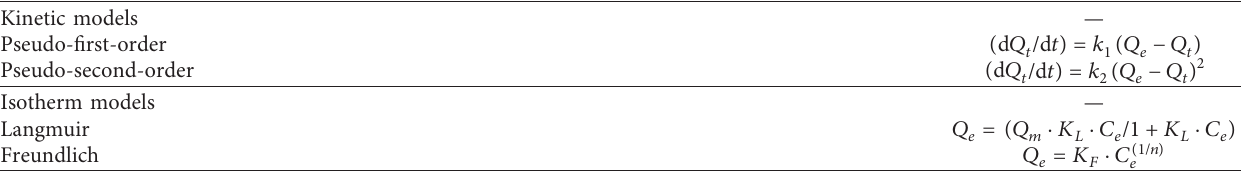
Table 1: The equations of the models used in this work.